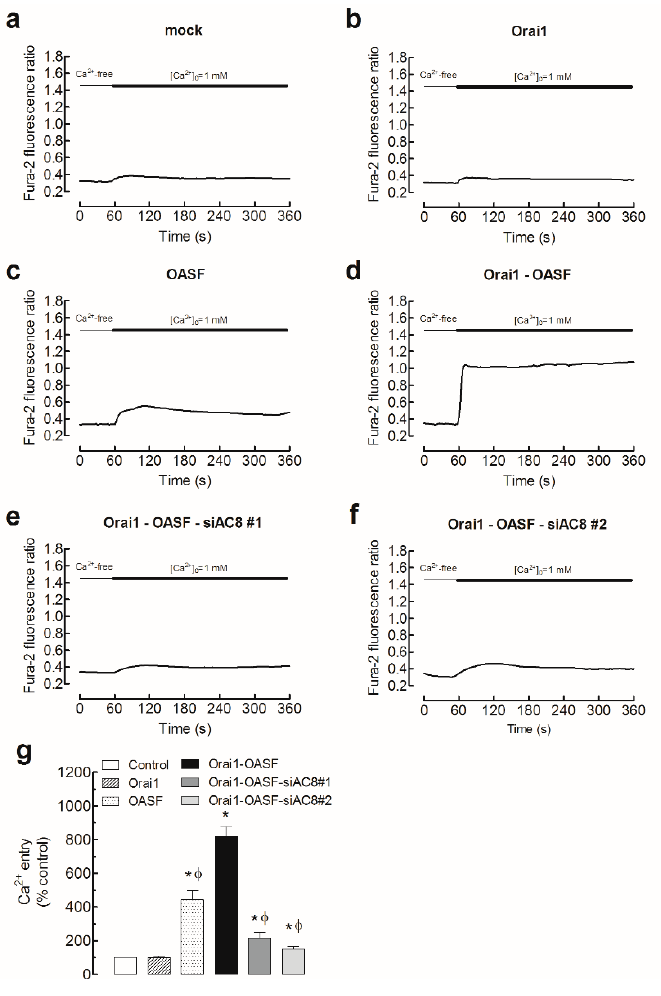
Figure 5. AC8 silencing attenuates Ca 2 + influx mediated by Orai1-activating small fragment (Orai1-OASF) in MDA-MB-231 breast cancer cells. MDA-MB-231 cells were transfected with Orai1 ( b ), OASF ( c ), both transfection plasmids ( d – f ), or empty vector (mock, a ), as indicated. Cells were also transfected with siAC8#1 ( e ), siAC8#2 ( f ), or scramble plasmid ( d ). Forty-eight hours after transfection, fura-2-loaded cells were perfused with a Ca 2 + -free medium (100 µ M EGTA added), followed by reintroduction of external Ca 2 + (final concentration 1 mM) to initiate Ca 2 + entry. ( g ) Bar graphs represent Ca 2 + entry in MDA-MB-231 cells transfected with the indicated plasmids. Data are expressed as means ± SEM of 40 cells / day / 3–5 days and presented as a percentage of control cells; * p < 0.05 as compared to control, φ p < 0.05 as compared to cells transfected with Orai1 and OASF expression plasmids and scramble